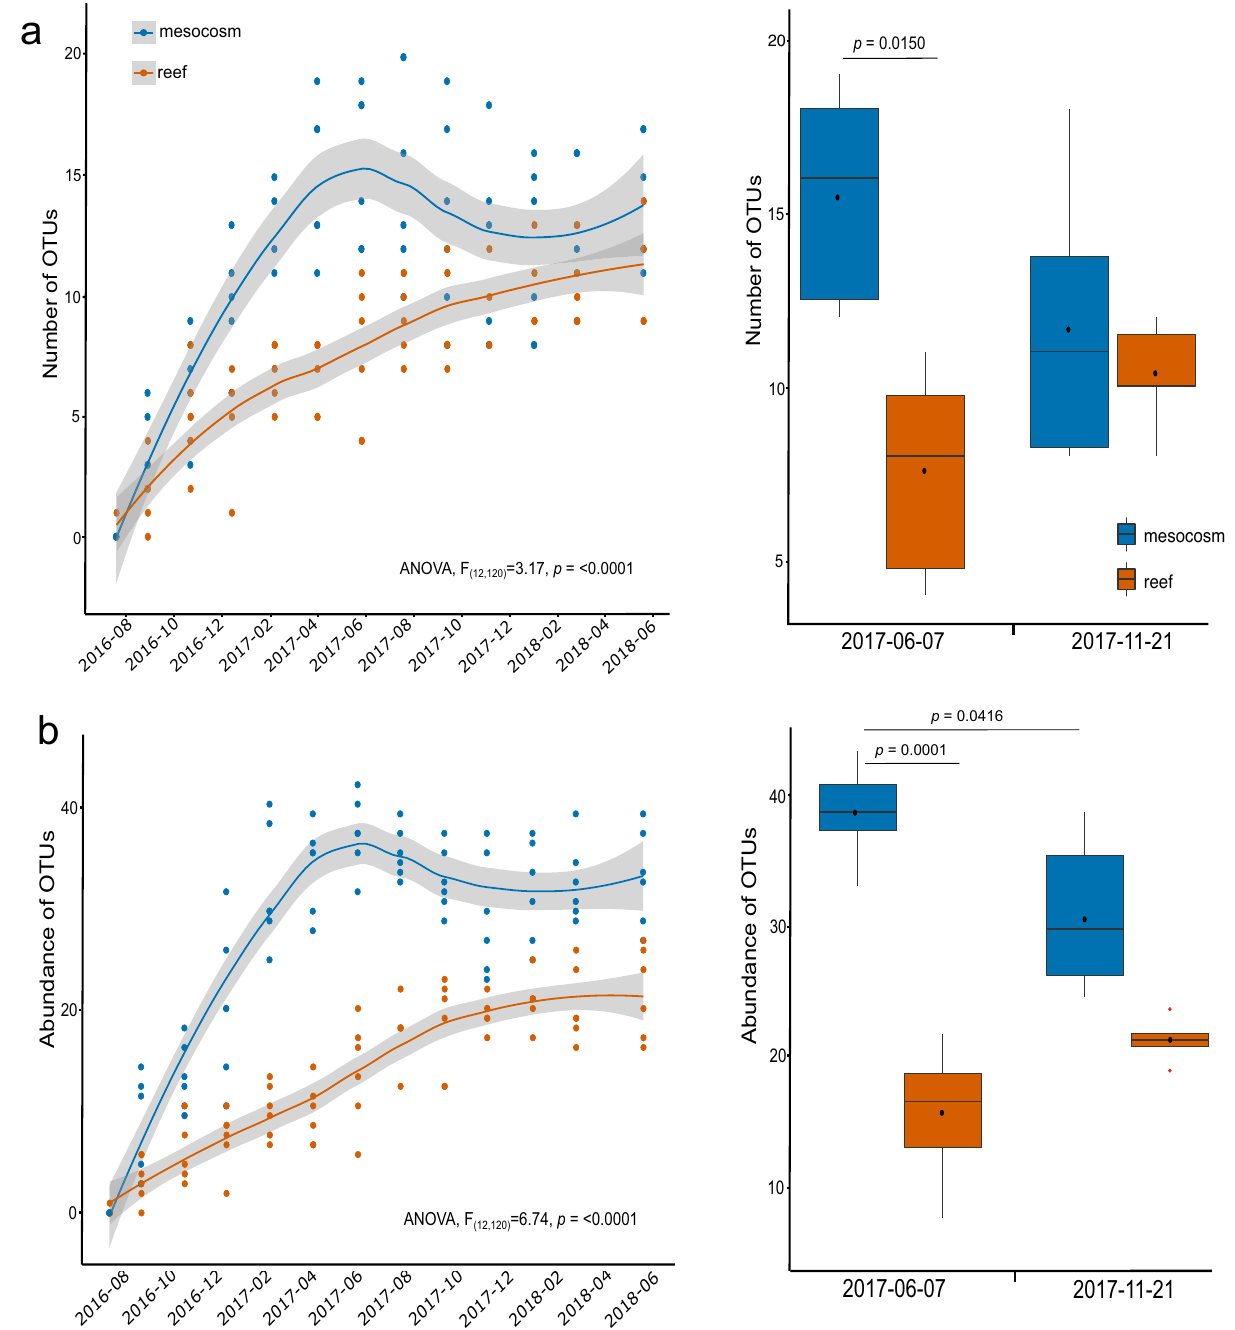
Figure 2. Temporal recruitment of ( a ) sponge OTUs and ( b ) abundance of OTUs settling on mesocosm and reef ARMS in Kāne ʽ ohe Bay. The left panel shows temporal recruitment, monitored bimonthly for approximately 2 years (July 2016 through June 2018). Peak diversity and abundance were observed at 11 months (June 2017) and was lowest at 16 months (November 2017) thereafter. Significant ANOVA results of the interactive effects of time and habitat are reported. Significant differences in diversity/abundance between the two time points (right panel) were observed in mesocosm ARMS as indicated by significant p values of Tukey’s post-hoc pairwise comparisons. Significant differences were also observed between mesocosm and reef ARMS. Line graphs are presented with lower and upper pointwise confidence intervals. Boxplots show median values as bars for each habitat; boxes show the upper and lower quartile; whiskers indicate the least and greatest value, excluding outliers. Mean values are shown as black circles and red circles are